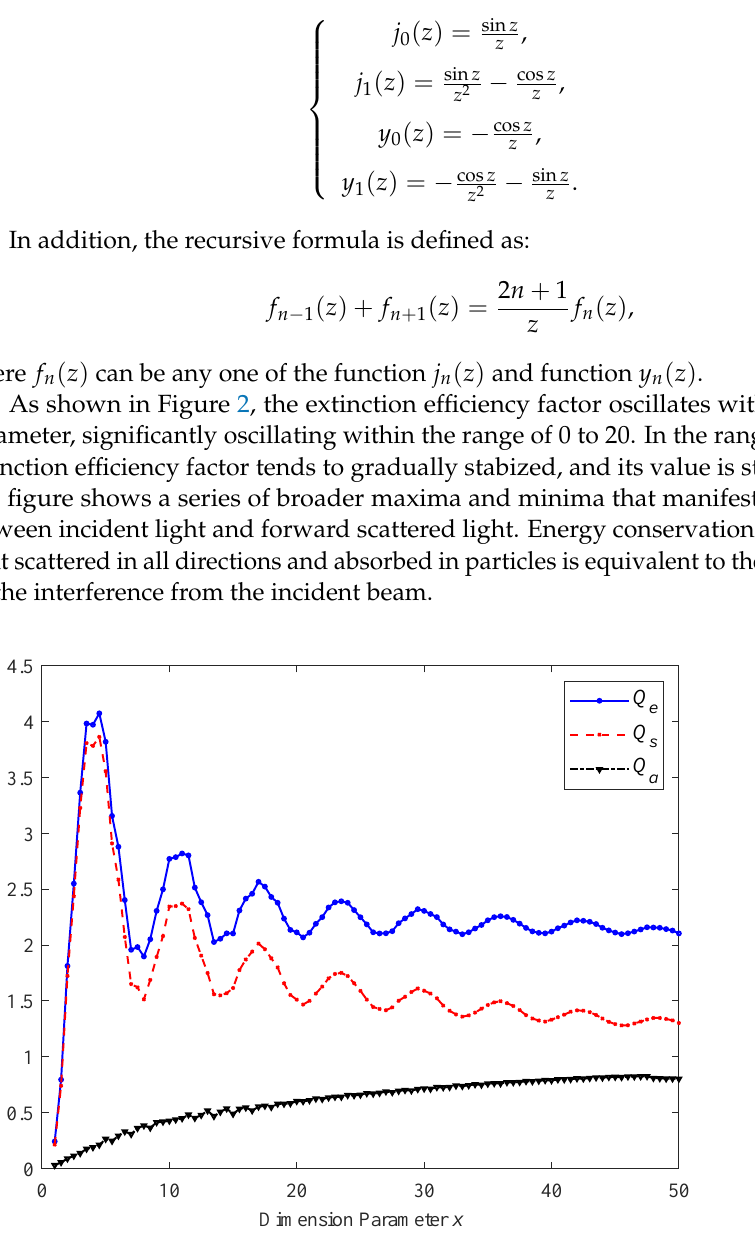
Figure 2. Relationship between dimension parameter x and efficiency